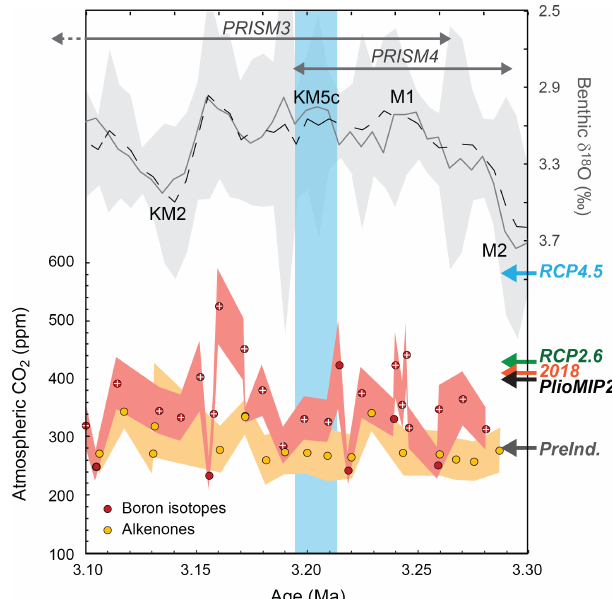
Figure 1. The KM5c interglacial during the late Pliocene (3.195– 3.215Ma). Upper part of graph: benthic oxygen isotope stack (solid line: LR04, Lisiecki and Raymo, 2005; dashed line and grey shad- ing: Prob-stack mean and 95% confidence interval, respectively, Ahn et al., 2017). Selected Marine Isotope Stages (KM2 through to M2) are highlighted. The KM5c interval of focus here is indi- cated by the shaded blue bar. Previous Pliocene synthesis intervals are also shown: PRISM3 (3.025–3.264Ma) and PRISM4 (isotope stages KM5c–M2; Dowsett et al., 2016). Lower part of graph: re- constructed atmospheric CO 2 concentrations (Foster et al., 2017). Points show mean reported data (except white crosses: median val- ues from Martinez-Boti et al., 2015); shading shows reported upper and lower estimates. Past and projected atmospheric CO 2 concen- trations highlighted by arrows: PlioMIP2 simulations are run with CO 2 at 400ppmv (Haywood et al., 2020) close to the annual mean in 2018 (NOAA). Pre-industrial values from ice cores (Loulerge et al., 2008) and projected representative concentration pathways (RCP) for 2100CE (IPCC,